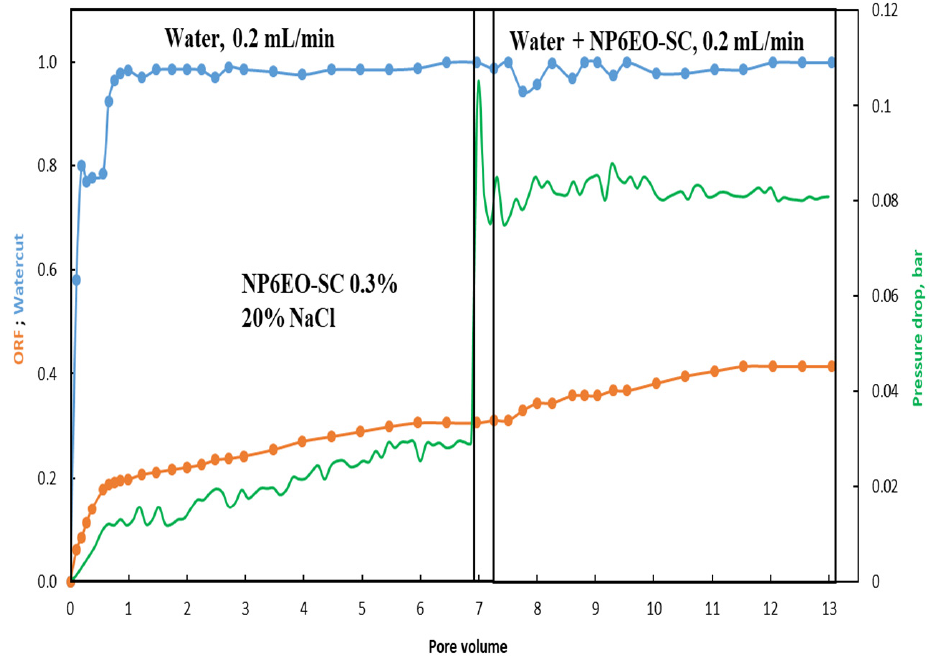
Figure 9. Oil displacement experiment of NP6EO–UOSN flooding.